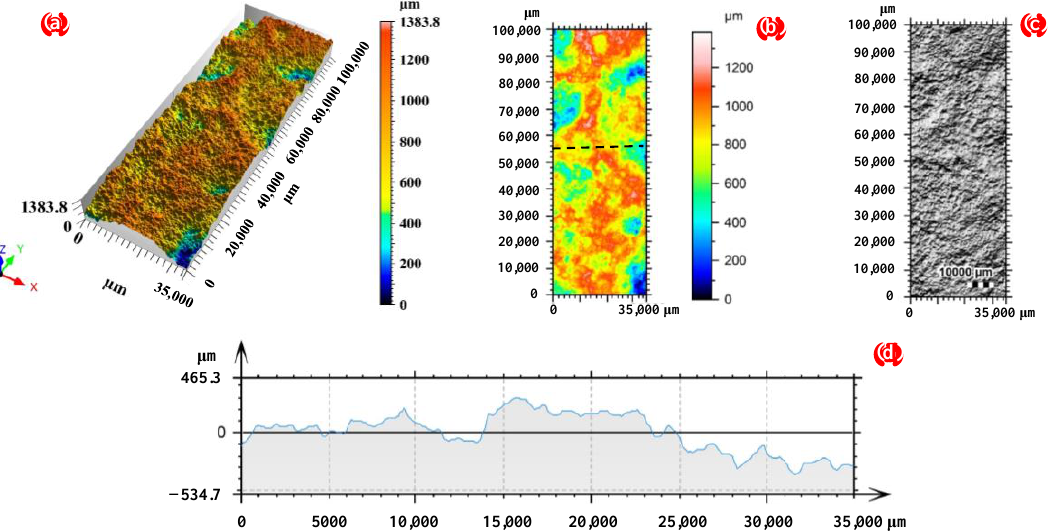
Figure 4. Three-dimensional morphology scanning results of the front side of C18-1: ( a ) 3D view of the surface, ( b ) pseudo color view of the surface, ( c ) photo copy, and ( d ) profile curve.